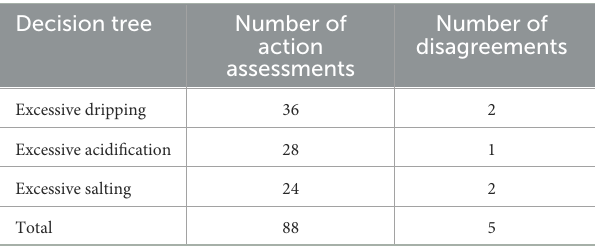
TABLE 1 Assessment of the efficiency aggregation method. Decision